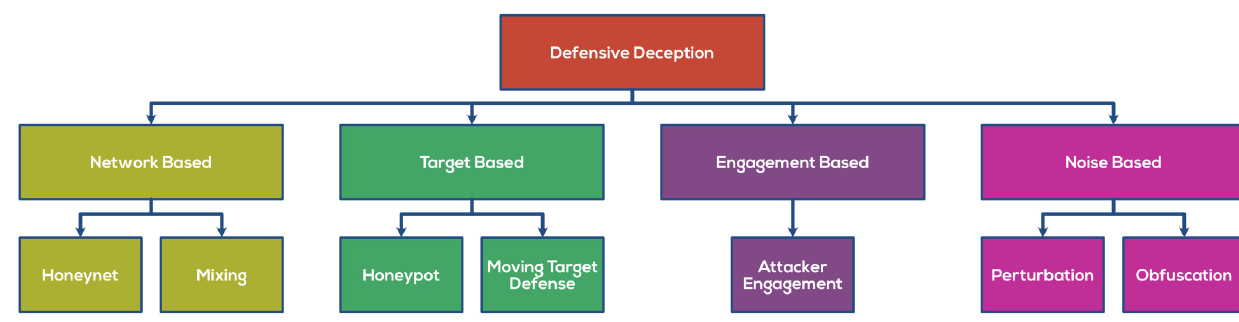
Figure 4. Methods to implement Defensive Deception. Table 5. Classification of several deception